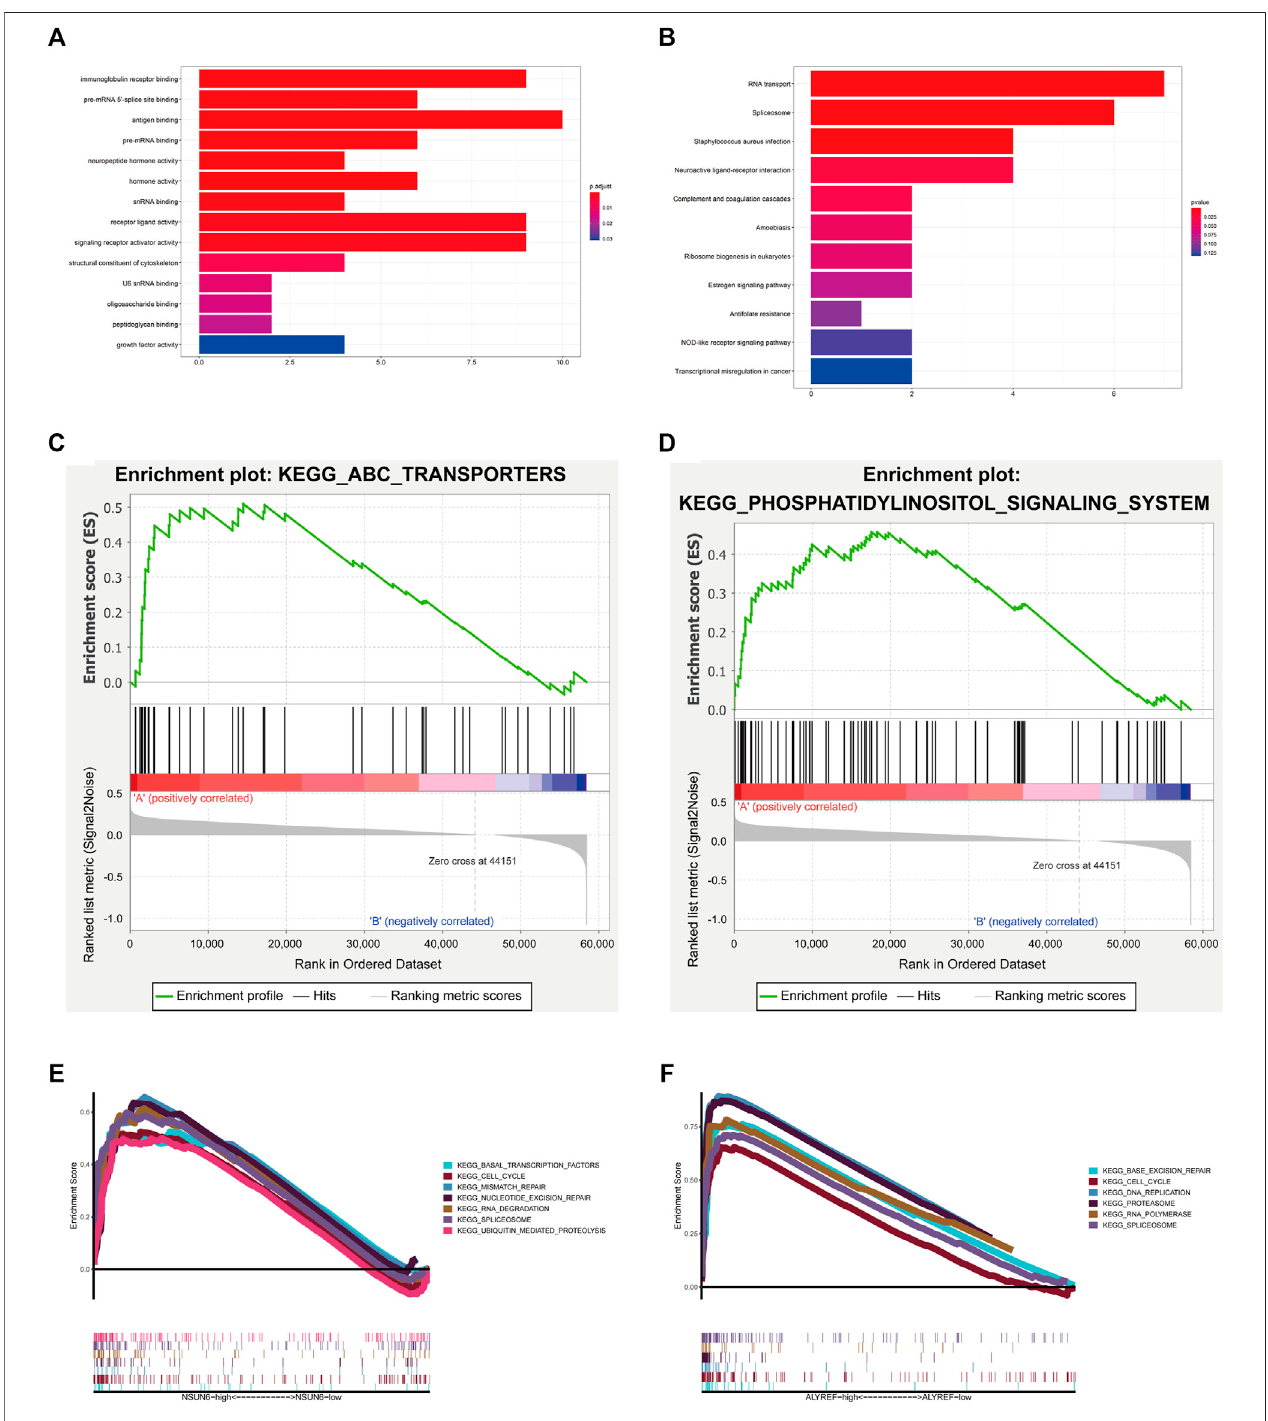
FIGURE 10 | Biological functional analysis. (A,B) GO analysis and KEEG pathways analysis of the genes signi fi cantly upregulated or downregulated between cluster Ⅰ and cluster Ⅱ . (C,D) Cluster I had a worse overall survival and lower 5-year survival rate associated with malignancy-associated pathways, including the ATP- binding cassette transporter and phosphatidylinositol signaling system. (E) GSEA results for NSUN6 in COAD. (F) GSEA results for ALYREF in COAD.